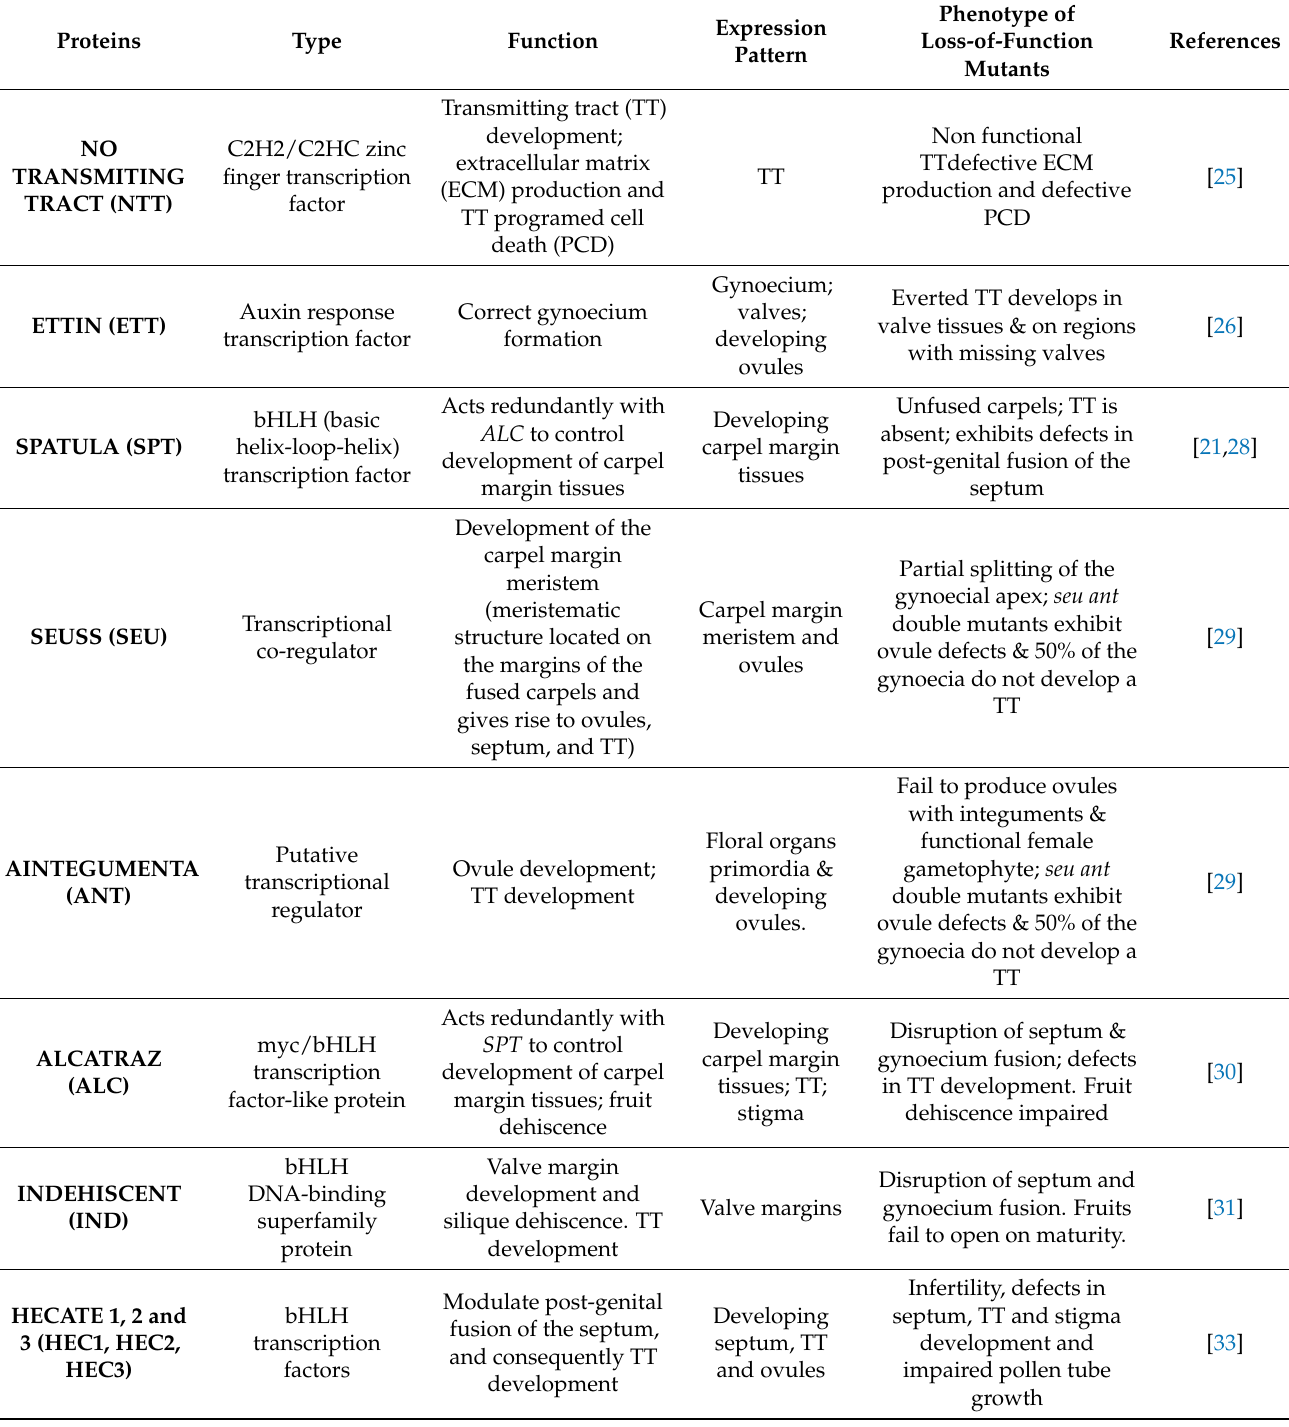
Table 1. List of the key players that are involved in TT formation and development in Arabidopsis thaliana